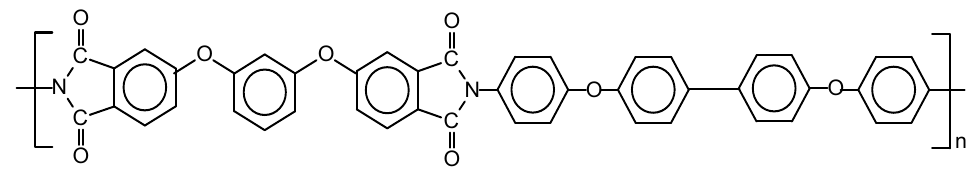
Figure 1. Chemical structure of the polyimide R-BAPB.